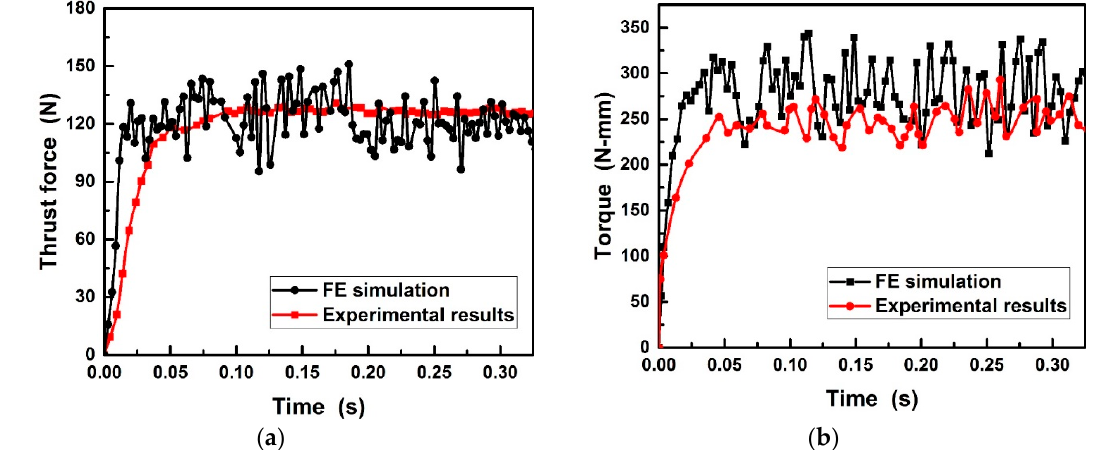
Figure 11. Comparison of ( a ) thrust force and ( b ) torque between FE simulation and drilling experiment performed during drilling Al6063/SiC p /65p composites using CVD diamond coated drill.